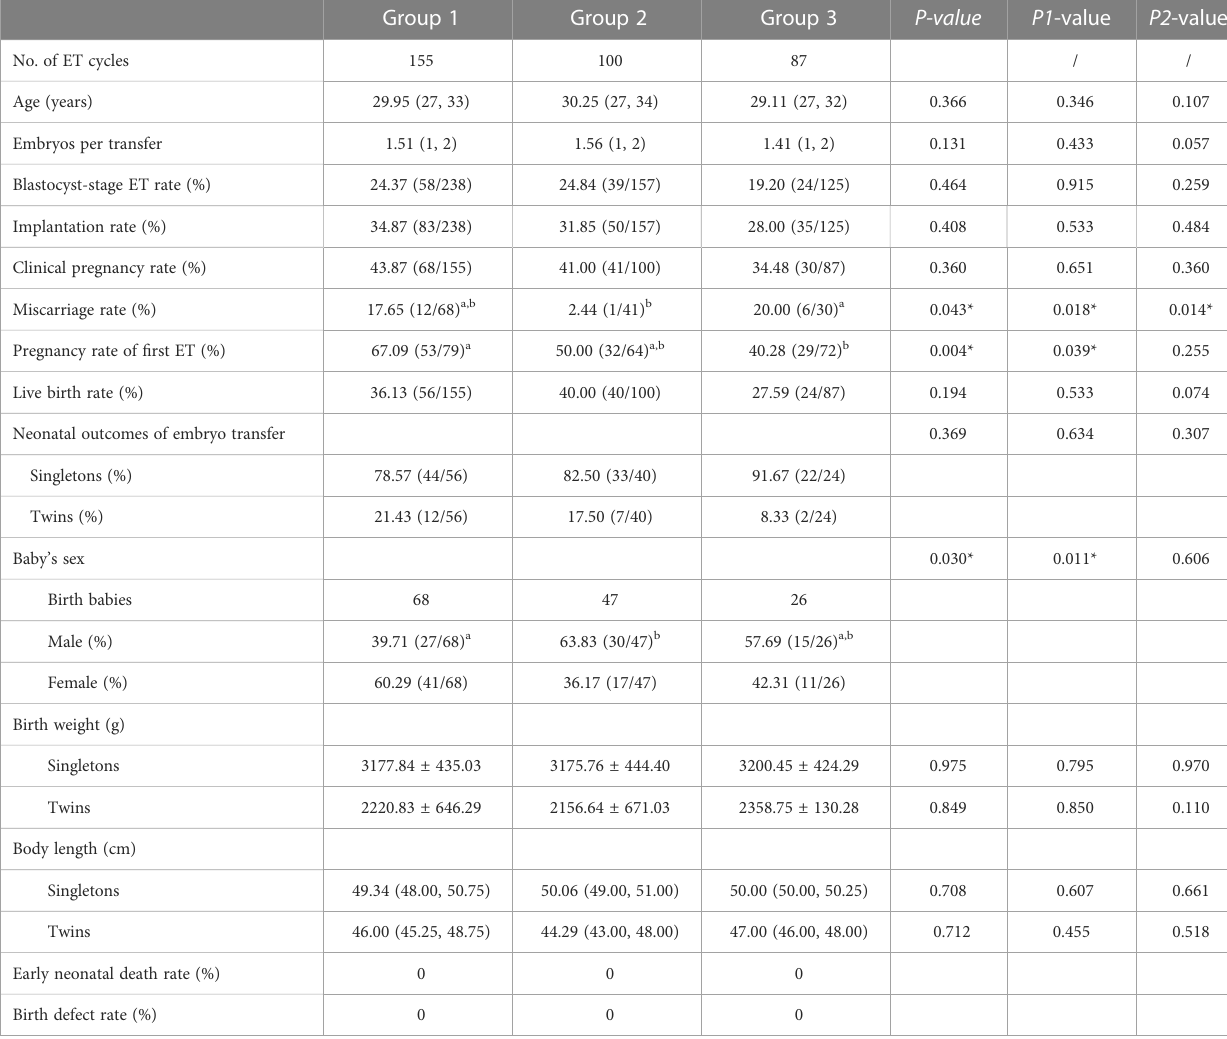
TABLE 3 Comparison of clinical outcomes between AOA and non-AOA after motile or immotile sperm